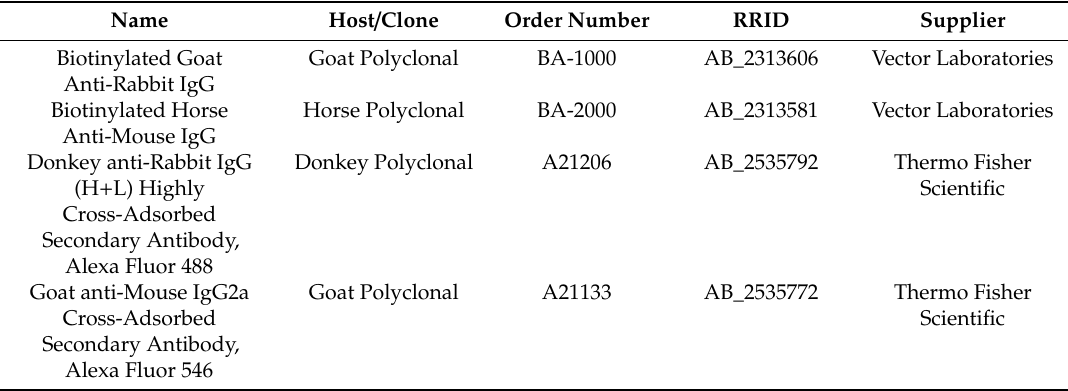
Table 2. Secondary antibodies used in this